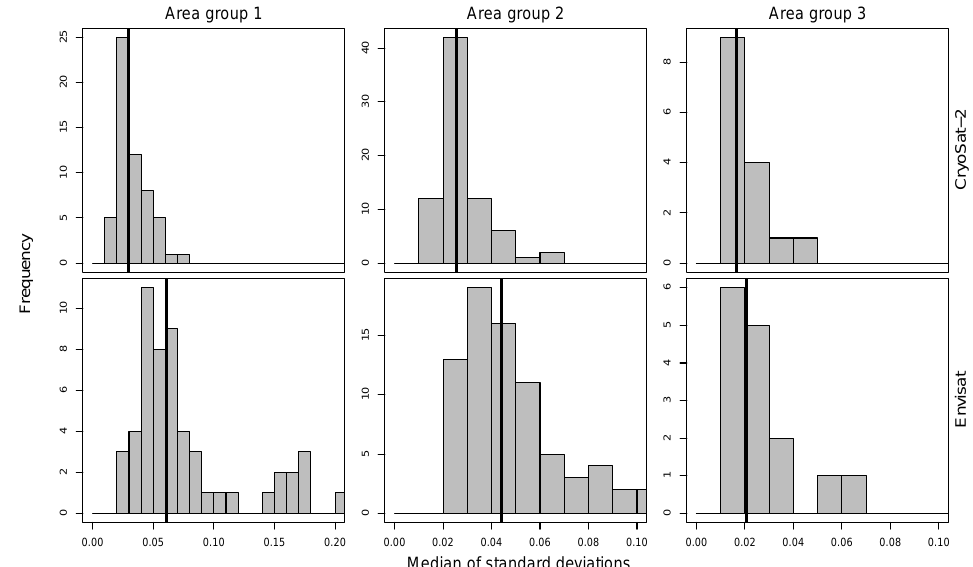
Figure 5. Histograms of MSD for CryoSat-2 and Envisat in the three area groups; group 1 ( < 100 km 2 ), group 2, (100–1000 km 2 ), and group 3 ( > 1000 km 2 ). The vertical black line indicates the median of the